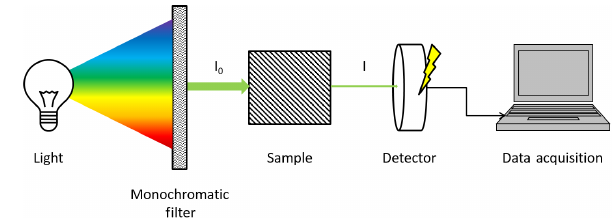
Figure 1. Sketch of the components of a simplified optode